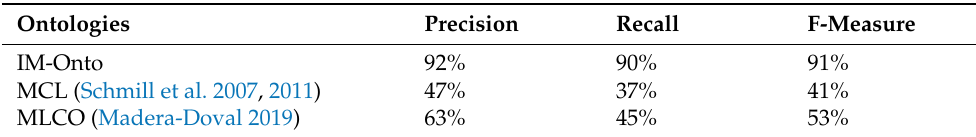
Table 5. Precision and recall rates for comparing ontologies.